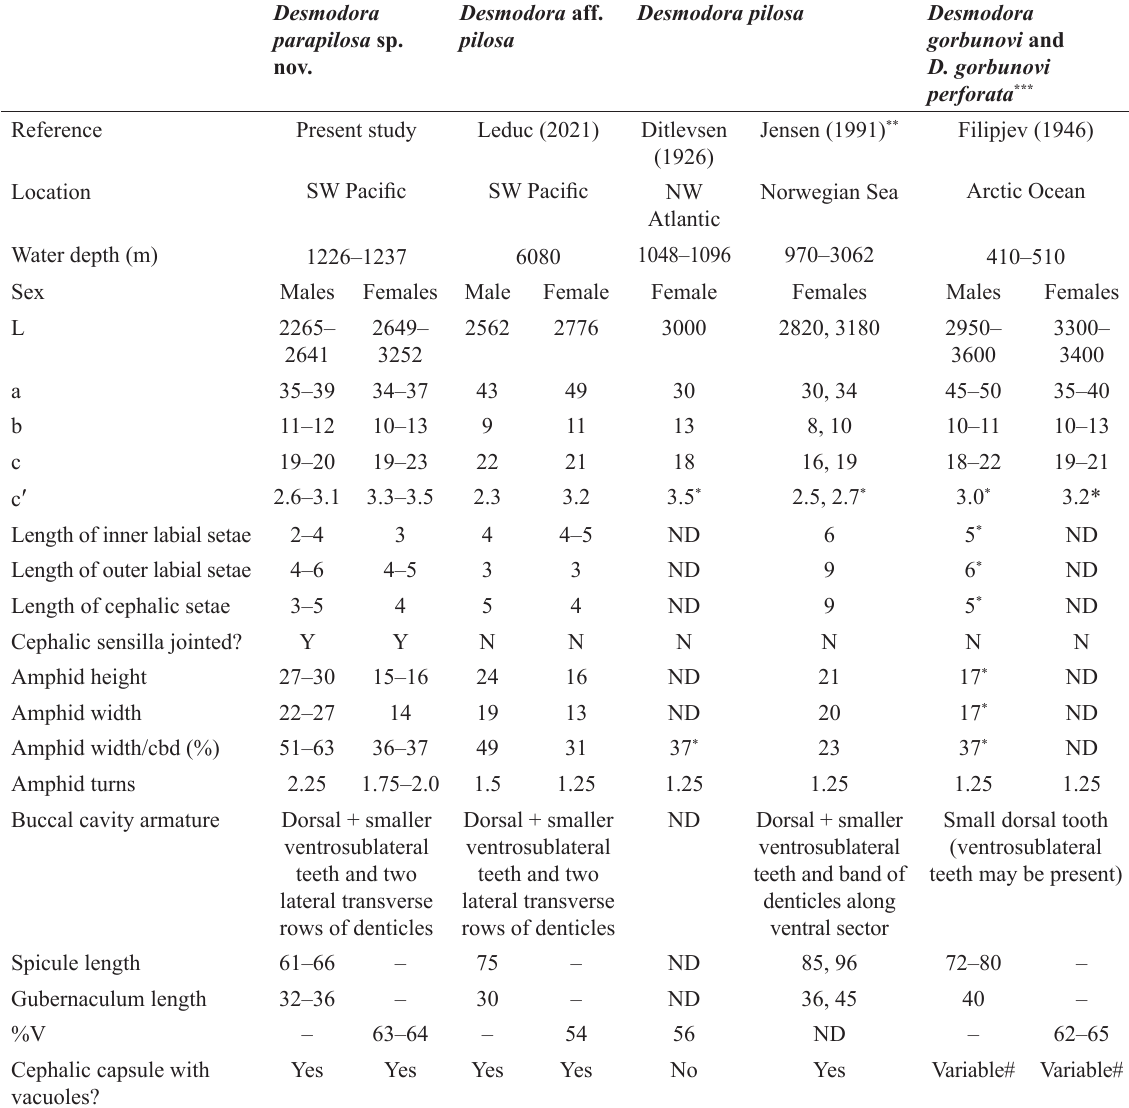
Table 8. Comparison of morphometric data of Desmodora parapilosa sp. nov. and Desmodora pilosa Ditlevsen, 1926 from the literature (modified from Leduc 2021). Abbreviations: ND = no data; * = estimated from figure; ** = morphometric data of females not provided; *** = Desmodora gorbunovi Filipjev, 1946 and D. gorbunovi perforata Filipjev, 1946 were synonymised with D. pilosa by Gerlach (1963); # = Pores present in D. gorbunovi perforata but absent in D. gorbunovi